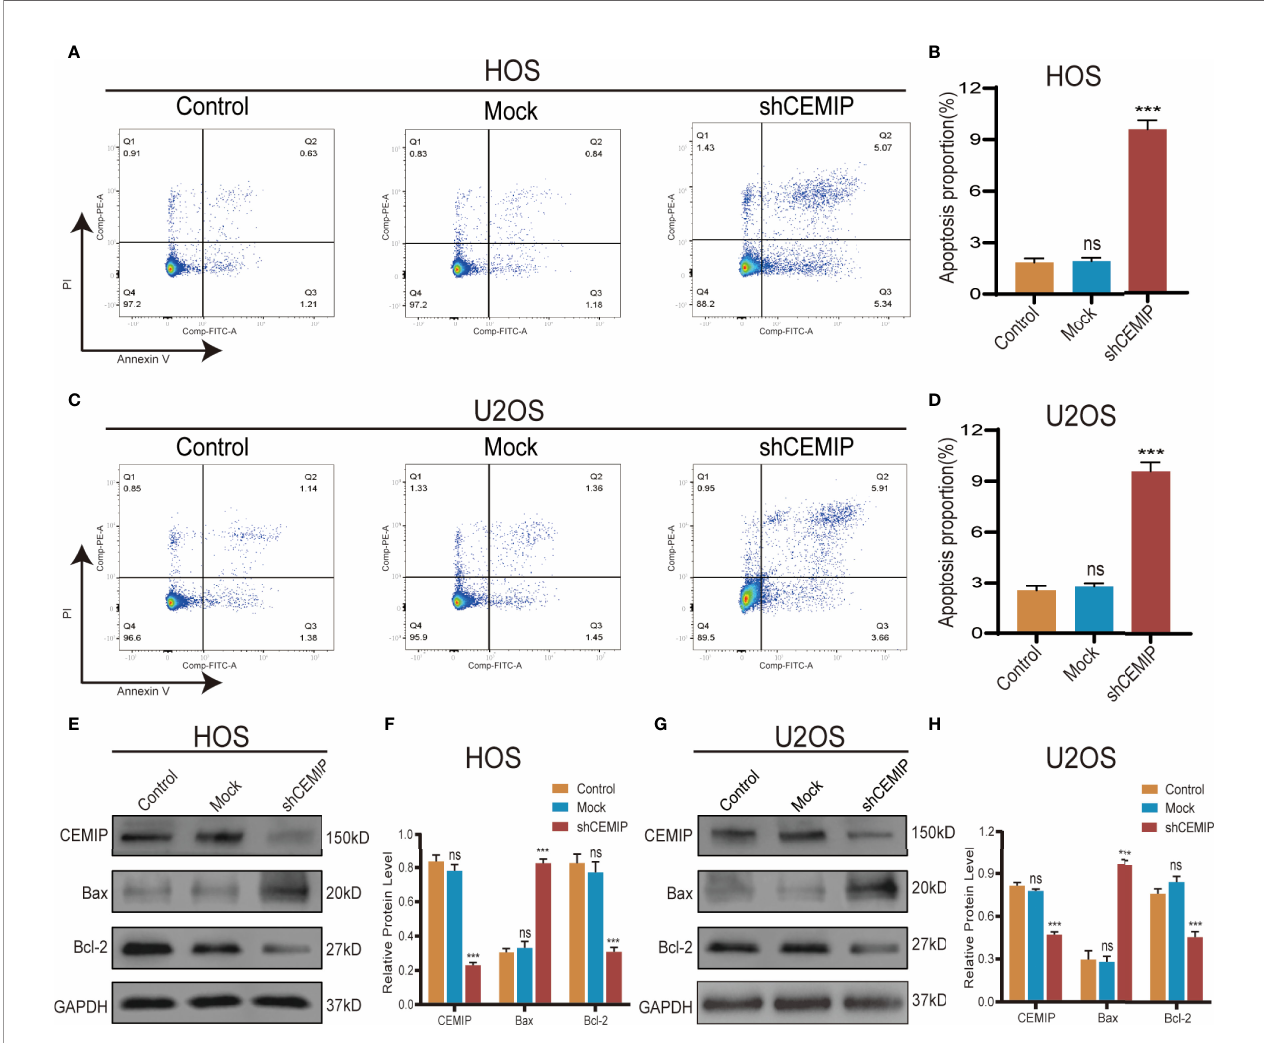
FIGURE 4 | CEMIP knockdown induces cell apoptosis. (A, B) The role of silencing CEMIP on apoptosis of HOS cells were detected by fl ow cytometry assays and its quantitative analysis. (C, D) The role of silencing CEMIP on the apoptosis of U2OS cells were detected by fl ow cytometry assays and their quantitative analysis. (E, F) Western blot showed the relative protein expression of apoptosis markers (pro-apoptotic marker, Bax; anti-apoptotic marker, Bcl-2) in HOS cells. (G, H) Western blot showed the relative protein expression of apoptosis markers (pro-apoptotic marker, Bax; anti-apoptotic marker, Bcl-2) in U2OS cells. *** P < 0.001. ns, no signi fi